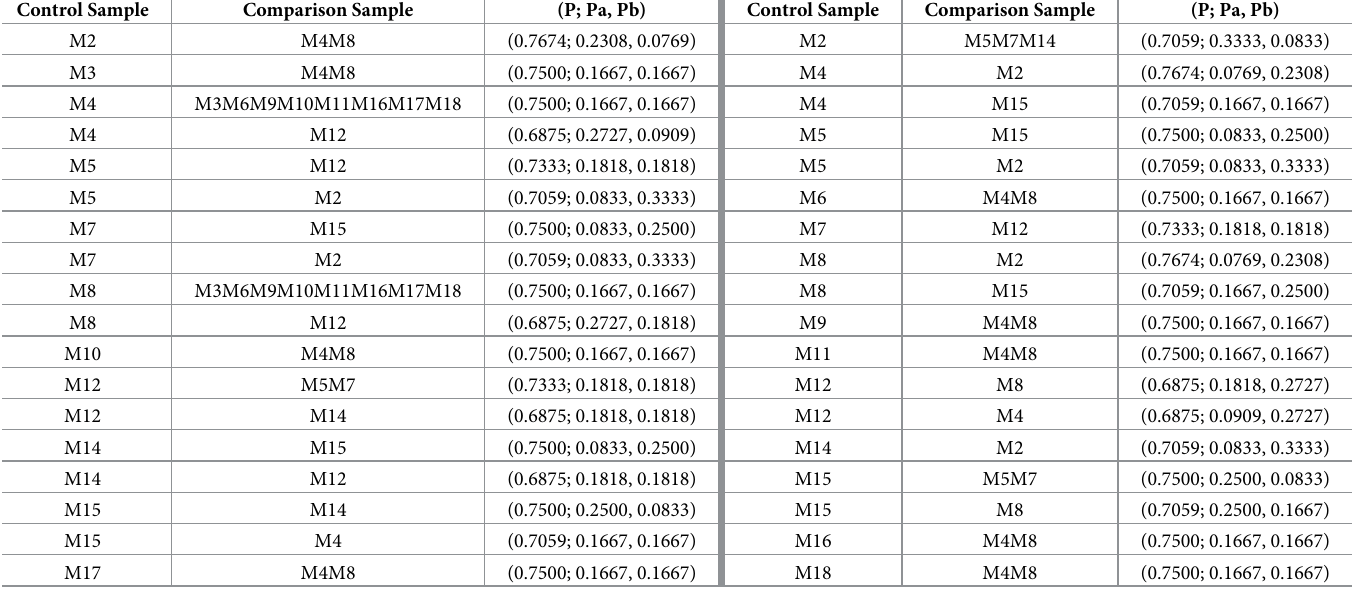
Table 8. The sequence with low common peak rate and high variation peak rate (Group